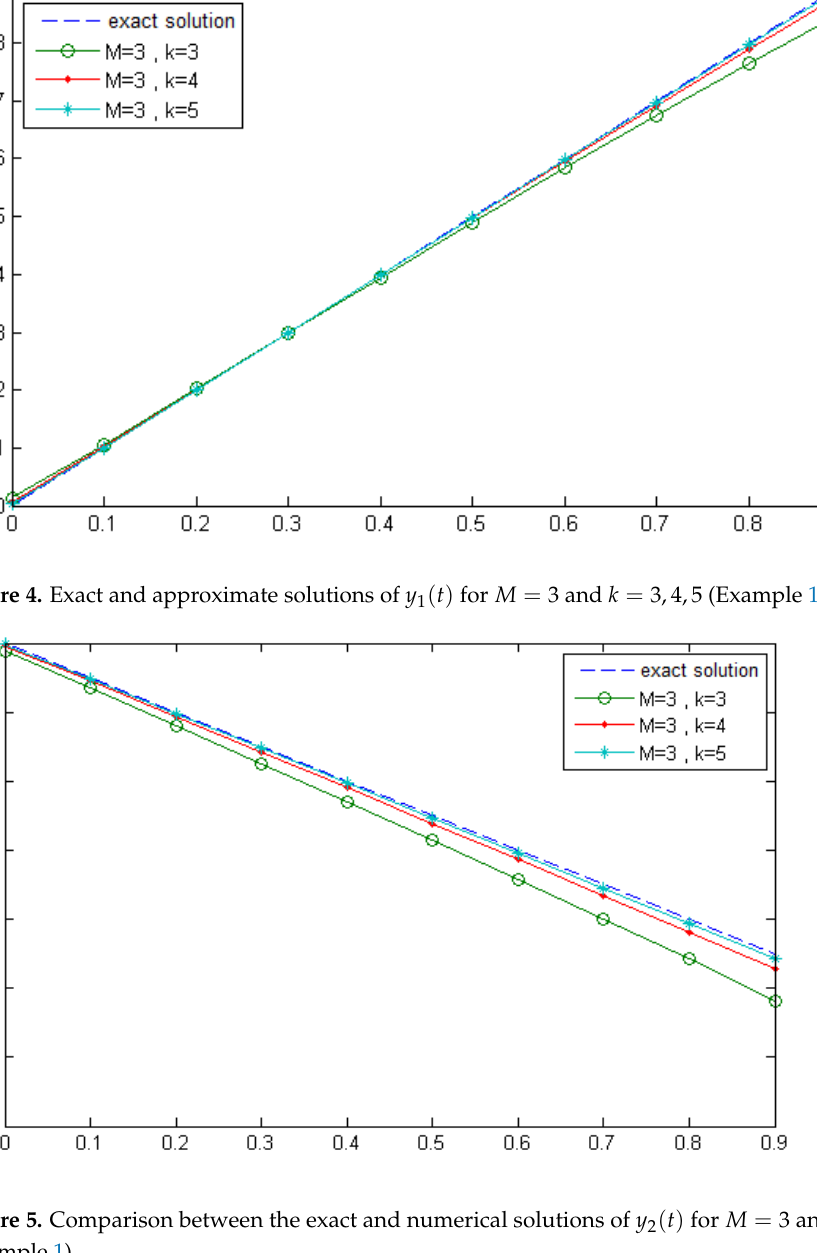
Figure 5. Comparison between the exact and numerical solutions of y 2 ( t ) for M = 3 and k = 3,4,5 (Example